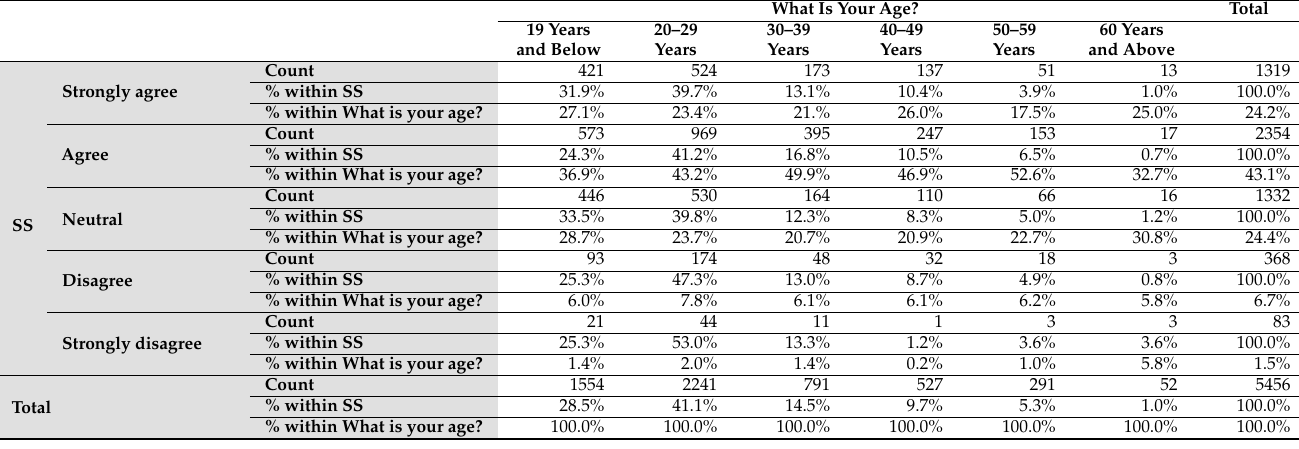
Table 20. Symbolic societal value of EVs and respondents’ age cross-tabulation.